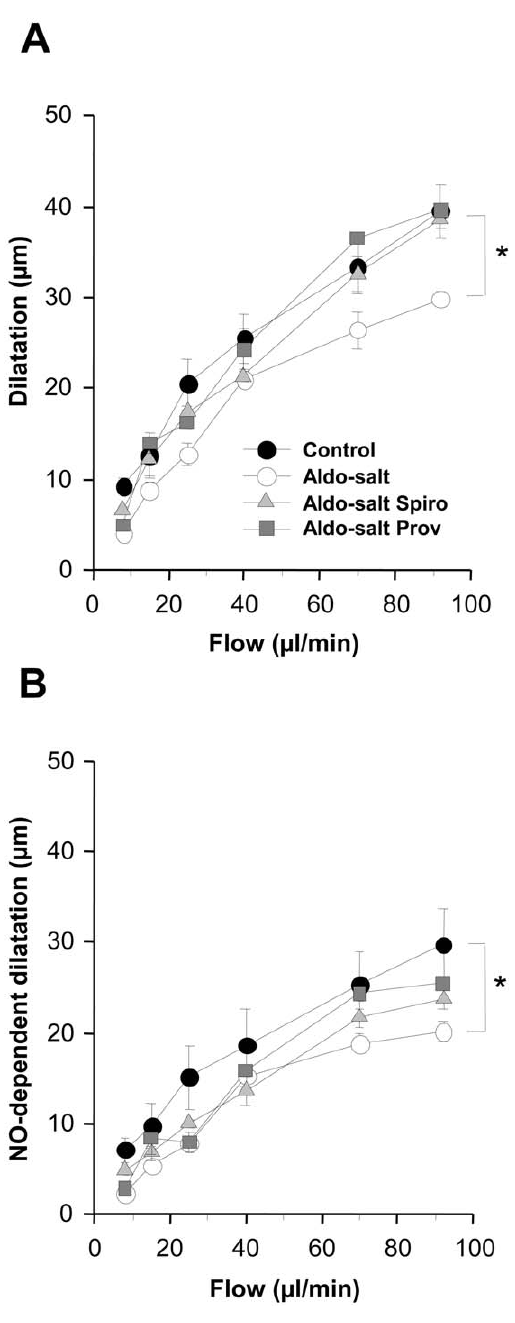
Figure 5. Endothelial function in small mesenteric arteries. A: Flow-induced dilatation in small mesenteric arteries from control, aldosterone-salt (Aldo-salt), aldosterone-salt spironolactone (Aldo-salt Spiro) and aldosterone-salt Provinols TM (Aldo-salt Prov) calculated as D diameter. Absolute values for baseline diameters were 133 6 9, 136 6 7, 142 6 5 and 153 6 6 m m, respectively. * P , 0.05 Aldo-salt vs control. B: NO-dependent dilatation calculated as the difference between the dilatation in basal conditions and the dilatation in the presence of N $ nitro-L-arginine (L-NA, 100 m M). Absolute values for baseline diameters ere 133 6 4, 135 6 4, 143 6 6 and 154 6 4 m m, respectively. n=5 for each group. Values are means 6 SEM. *P , 0.05 Aldo-salt vs control vessels.